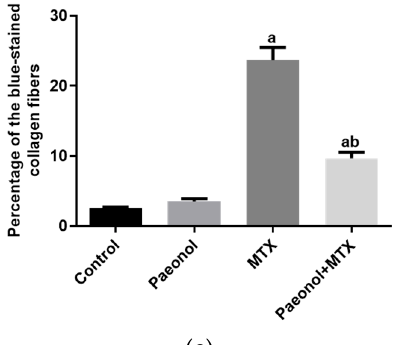
Figure 5. Photomicrographs showing the effect of paeonol on rat liver tissues stained with Masson’s trichrome in methotrexate (MTX)-induced hepatotoxicity (×400). The liver tissues of the control ( a1 , a2 ) and paeonol ( b1 , b2 ) groups show a minimal amount of blue-stained collagen (arrows), es- pecially around the central veins (CV) and portal area (squares). On the contrary, the liver tissues of the MTX-treated rats show an apparent increase in blue-stained collagen deposits (arrows) around the central veins (CV) and the portal area (square), with the appearance of collagen fibers running between and surrounding the hepatocytes (arrowhead) ( c1 , c2 ). In contrast, the liver tissues of the paeonol + MTX group show a minimal amount of collagen fibers (arrows) around the central veins (CV) and portal area (square) ( d1 , d2 ). A semi-quantitative analysis of the collagen fibers ( e ) summarizes the results of six experiments as mean ± SEM. Letters a,b Denote significant differences from the normal control and the MTX groups, respectively, at p ˂ 0.05.